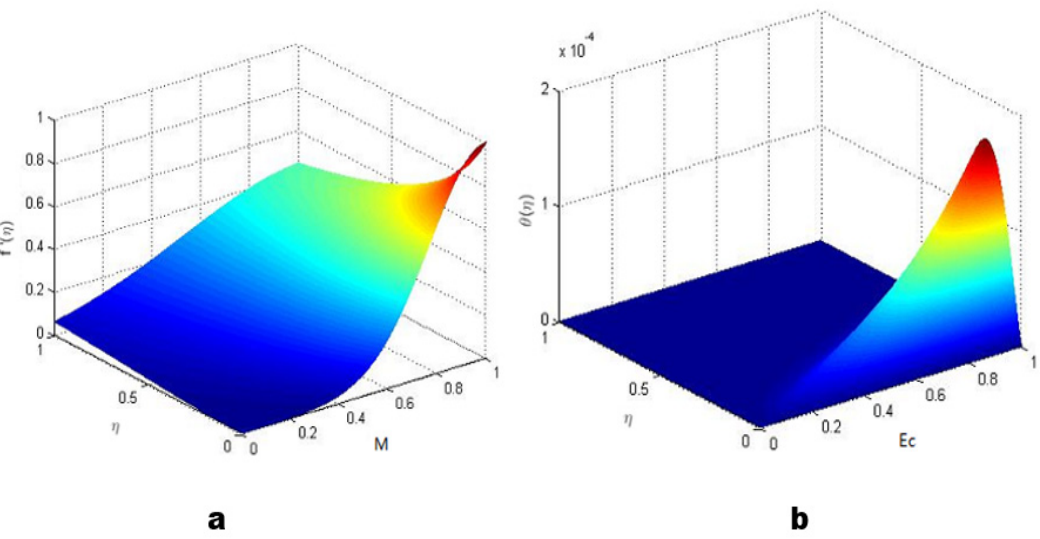
Figure 9. 3D representation of the velocity and temperature of AgNPS: ( a ) velocity and ( b ) temperature.